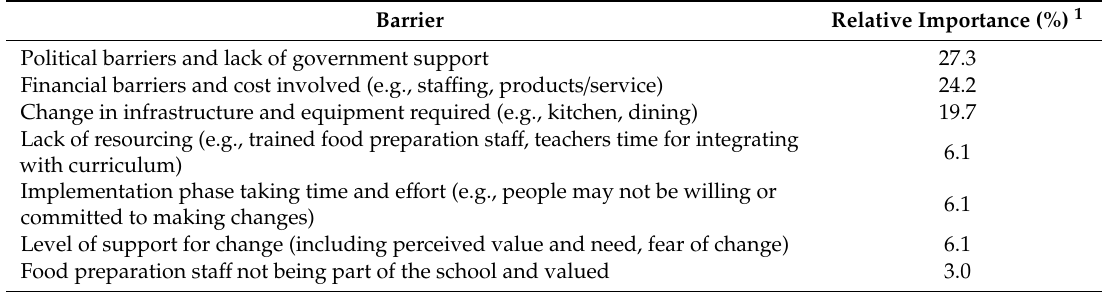
Table 3. Top five ranked barriers to changing the school food system from the consensus workshop. Barrier Relative Importance (%) 1